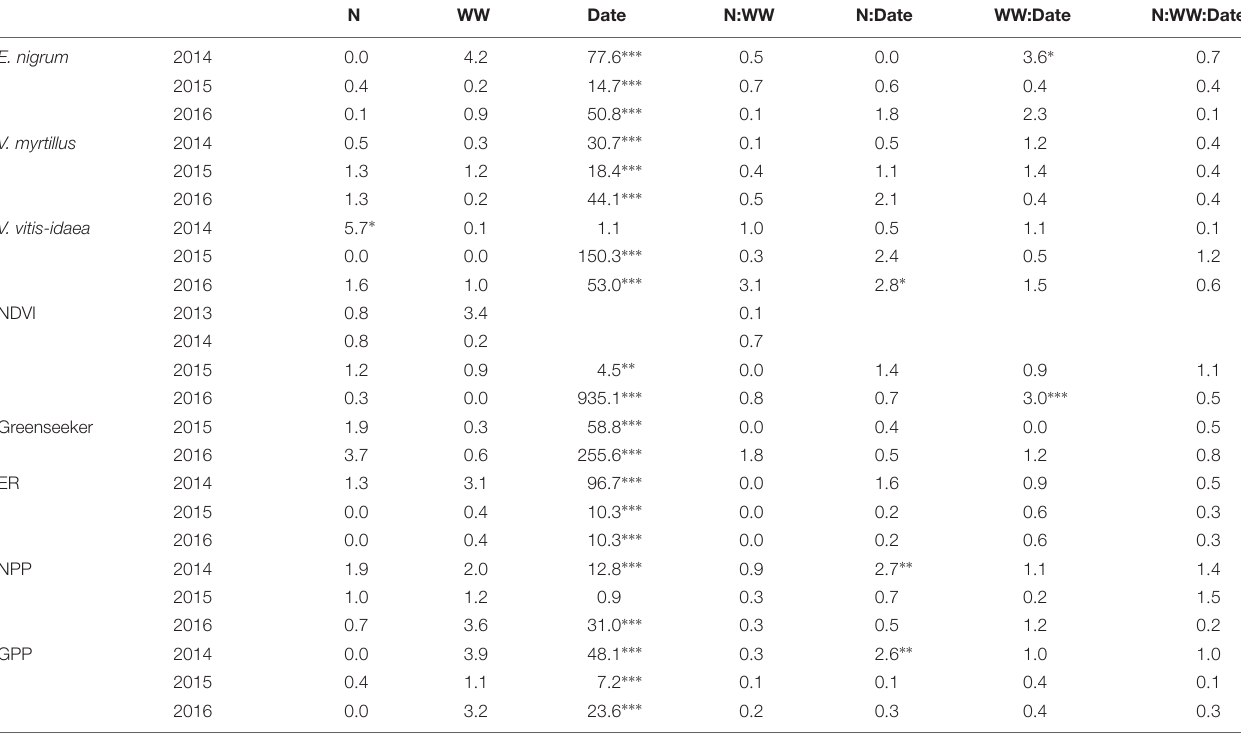
TABLE 1 | Repeated measures ANOVA results ( F -values) of leaf phenology, plot NDVI values and CO 2 gas fluxes in response to extreme winter warming events (WW), nitrogen additions (N) and their combination during three growing seasons. ∗ <0.05, ∗∗ <0.01, ∗∗∗ <0.001. N WW